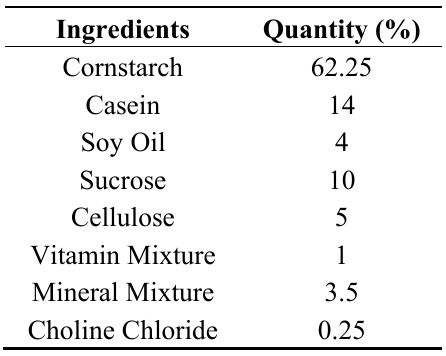
Table 1. Composition of the rat diet, based on AIN-93M.